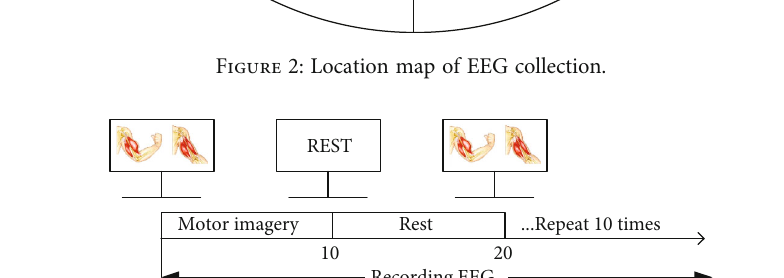
Figure 3: Experimental paradigm sequence